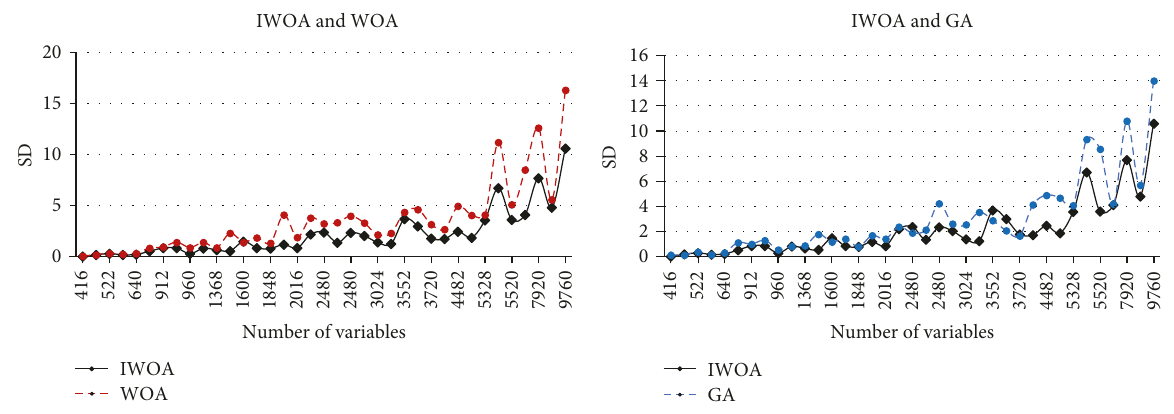
Figure 7: Boxplot diagrams for medium-scale instances.